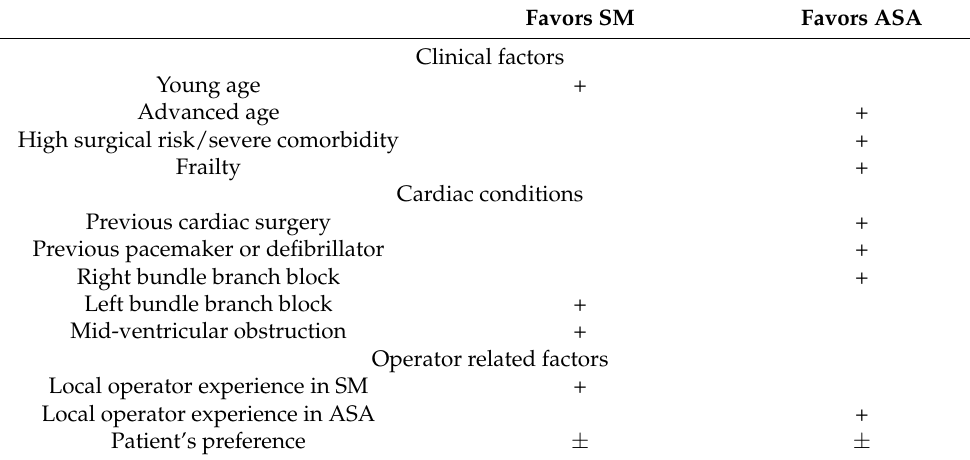
Table 1. Factors in decision-making for the invasive treatment of